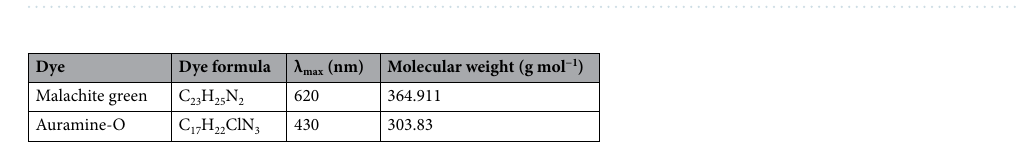
Table 1. The characteristics of the dyes.